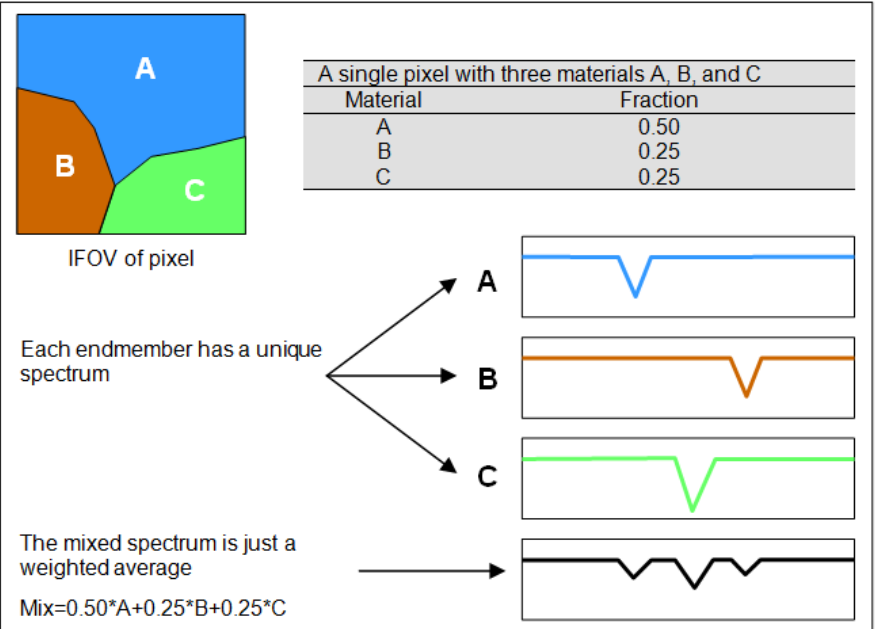
Figure 4. Principle of spectral mixing and unmixing (modified from [17], Figure 6, p. 48, with kind permission from Springer Science+Business Media